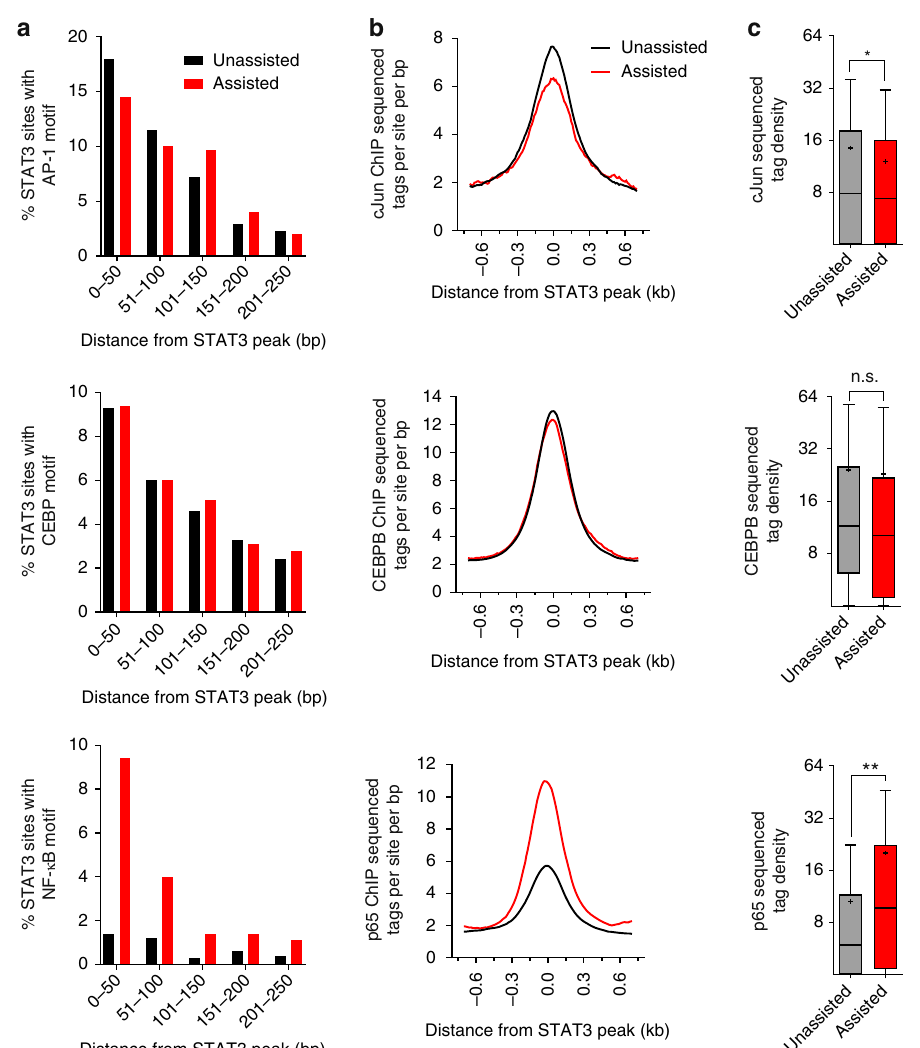
Fig. 5 p65 but not CEBPB or cJun preferentially binds at assisted sites. a The percent of STAT3 binding sites fl anking AP-1, CEBP and NF- κ B motifs shows an enrichment of NF- κ B motifs in the vicinity of assisted sites. Plotted as a function of distance of motif from center of STAT3 binding site (in 50 bp bins). b , c cJun, CEBPB and p65 binding following IL-1 β treatment in the vicinity of assisted or unassisted STAT3 binding sites shows an enrichment of p65 binding next to assisted sites. Asterisks denote statistical signi fi cance as determined by an unpaired, two-tailed t -test. Single asterisk denotes p -value ≤ 0.05, double asterisks denote p -value ≤ 0.01. NS denotes not signi fi